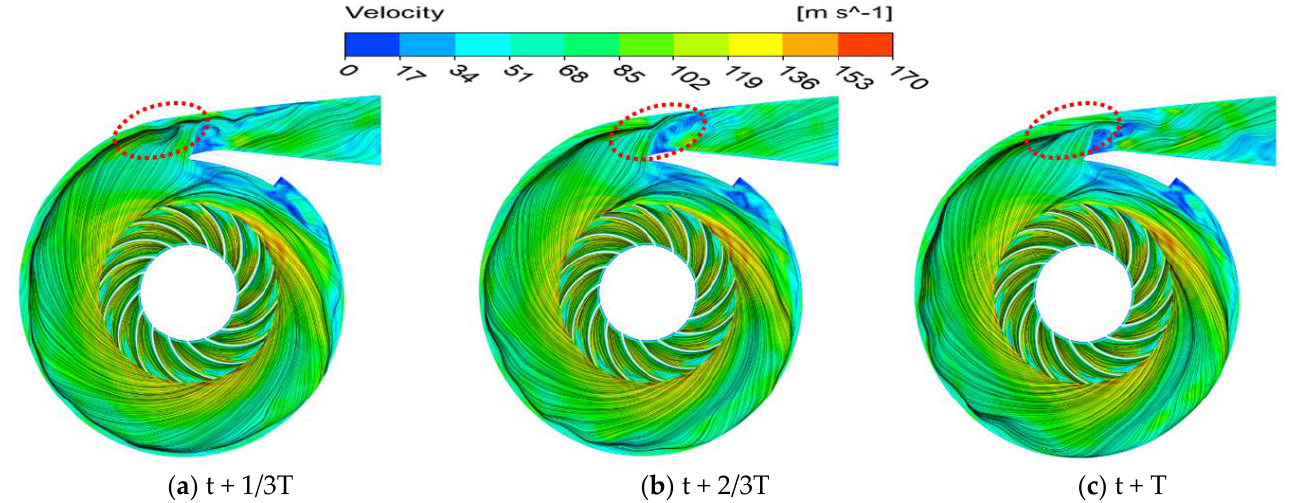
Figure 8. Development of the velocity and streamline at the z = − 12 mm cross-section and the high mass-flow rate(1.1 Qn 30.56 kg/s) from 0.0569 to 0.06259 s. Figure 9 exhibits the velocity field situation and streamline distribution at the z = − 12 mm cross-section and the near-stall mass-flow rate (0.8 Qn = 22.62 kg/s). In general, acom- plexity of internal flow is observed at a low mass-flow rate. The extreme inhomogeneity of the velocity field brings about an excessive velocity gradient. At a constant speed of 10,545 rpm, centrifugal and Coriolis forces intensify the effect on low-energy flow in the im- peller, accompanied by the squeezing of high-speed groups in the vaneless diffuser—which reveals that most streamlines are distributed in